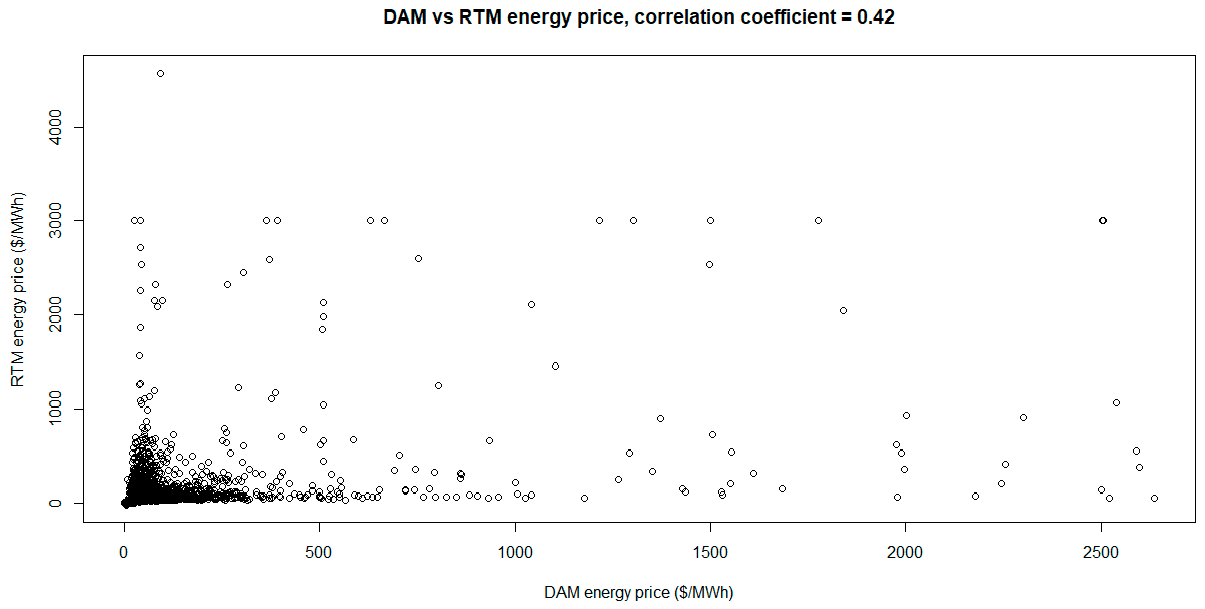
Figure 1. Scatter plot of hourly DAM energy price vs. hourly RTM energy price for the period of 01 January 2011 to 31 December 2017. The OLS regression based on the efficient market hypothesis is RTM price = a + b × DAM price + error, where a ≈ 0 and b ≈ 1 are the regression’s coefficient estimates. Updating the figure with more recent data does not change its key message: DAM and RTM prices move in tandem and are highly volatile with infrequent but large spikes.